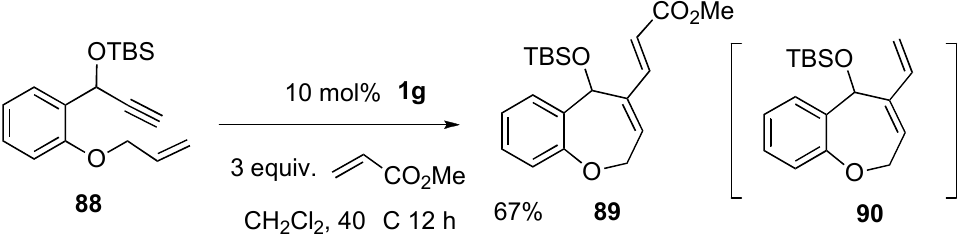
Scheme 26. One-pot reaction of